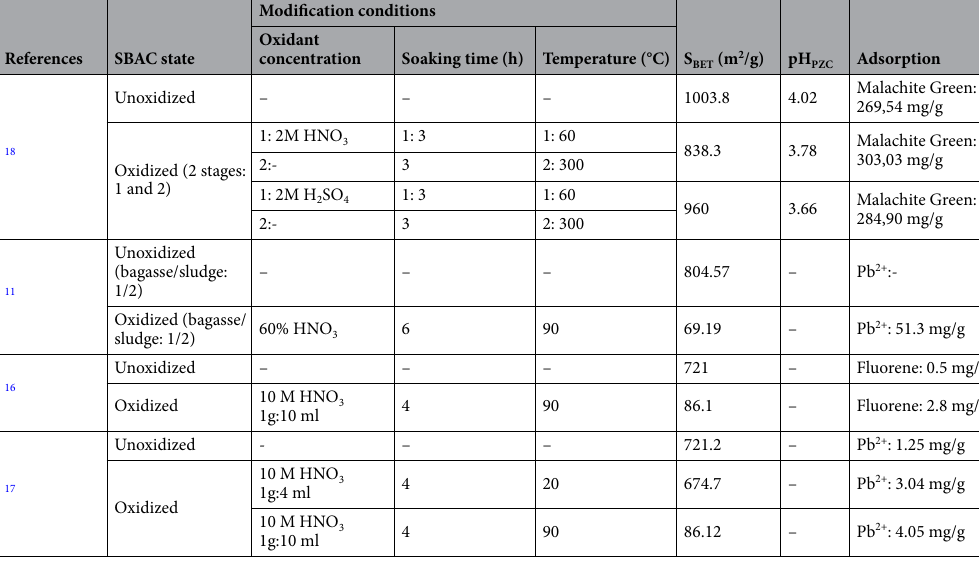
Table 1. Literature oxidized activated carbon extracted from sewage sludge (SBAC) and adsorption